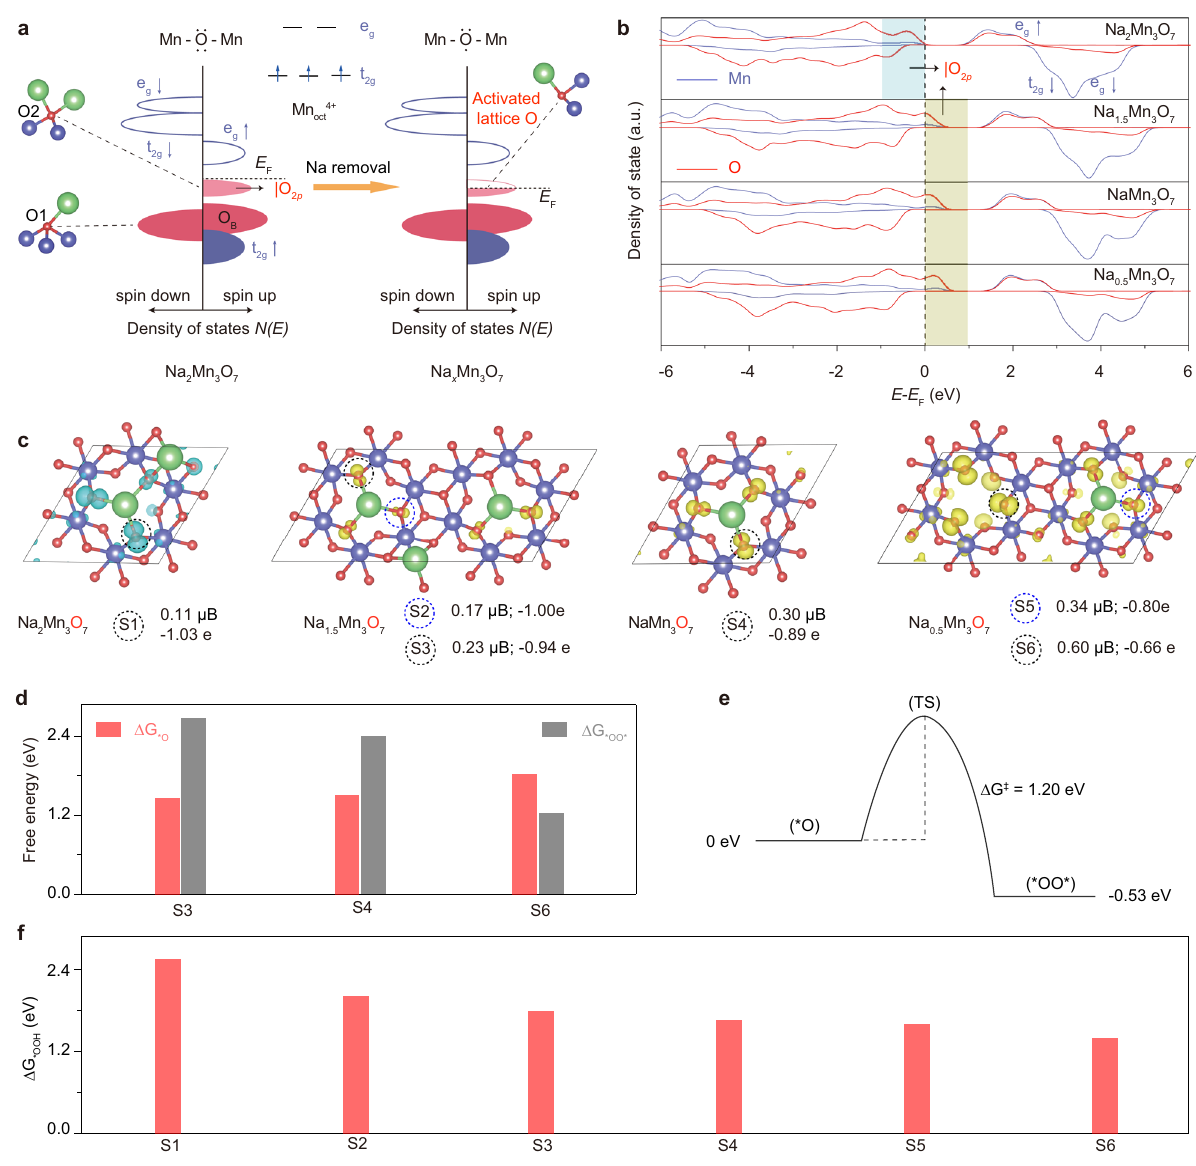
Fig. 1 Activating lattice oxygen to regulate the pathway competition for O – O bond formation. a Schematic formation of oxygen holes in |O 2 p lone-pair states for Na x Mn 3 O 7 . Lattice oxygen atoms are de fi ned as O1 and O2, where O1 is coordinated with three Mn ions and O2 is coordinated with two Mn ions, respectively. b Projected density of states of Na x Mn 3 O 7 slabs ( x = 2, 1.5, 1, and 0.5). c Partial charge density projected on O atoms by the shaded region shown in Fig. 1b. d Free energy difference between the two isomeric intermediates of A3 (*O) and R4 (*OO*) on representative oxygen coordination environments. The details about A3 and R4 are shown in Supplementary Fig. 4. e Activation free energy barrier ( Δ G ‡ ) from A3 to R4 on the speci fi c coordination environment of S6. f Free energy barrier ( Δ G *OOH ) for the formation of